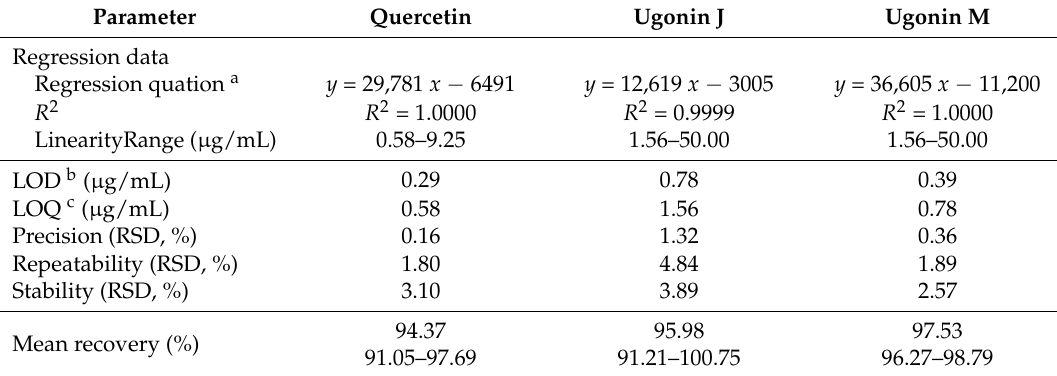
Table 1. Linearity, precision, repeatability, recovery, LOD, and LOQ of the established method. Parameter Quercetin Ugonin J Ugonin M Regression data Regression quation